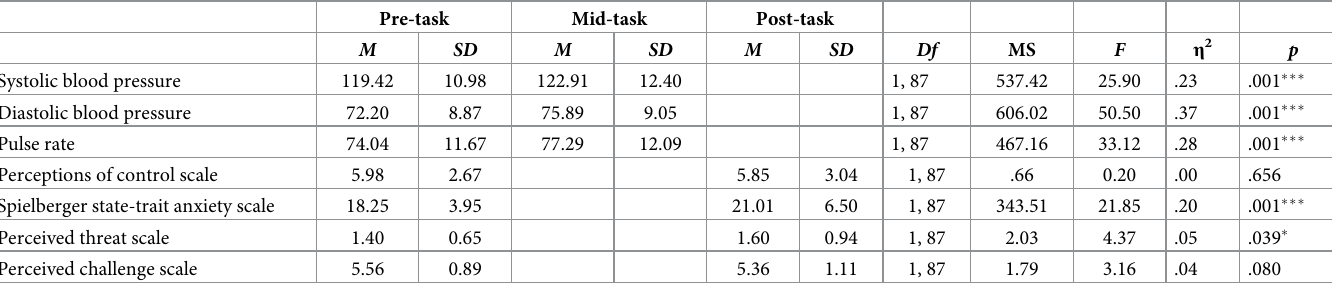
Table 2. Descriptive and ANOVA tests for supplementary